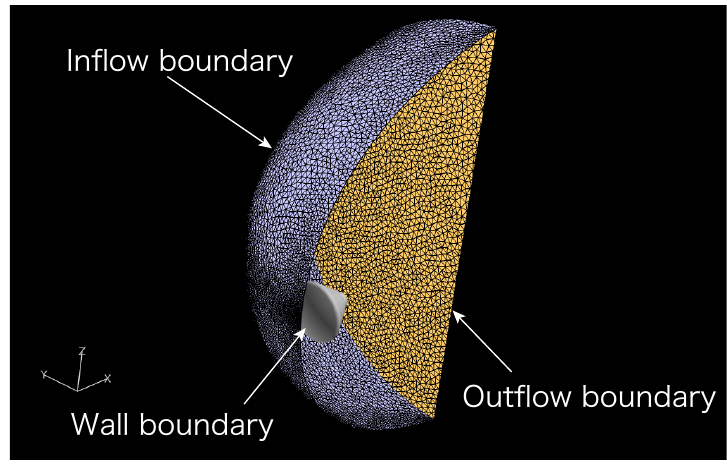
Figure 5. Computational domains and boundary conditions around the ESA ARD for plasma flow